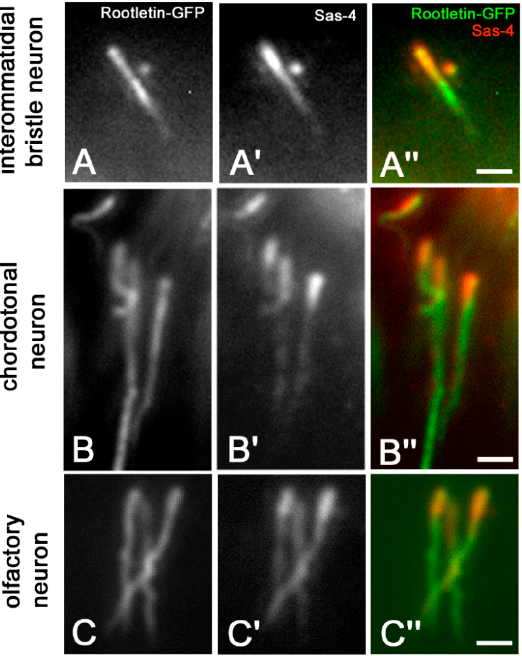
Figure 6. Colocalization of rootletin-GFP and Sas-4 in the interommatidial bristle ( A – A ″ ), chordotonal ( B – B ″ ) and olfactory ( C – C ″ ) neurons. Scale bars: 5 µm.